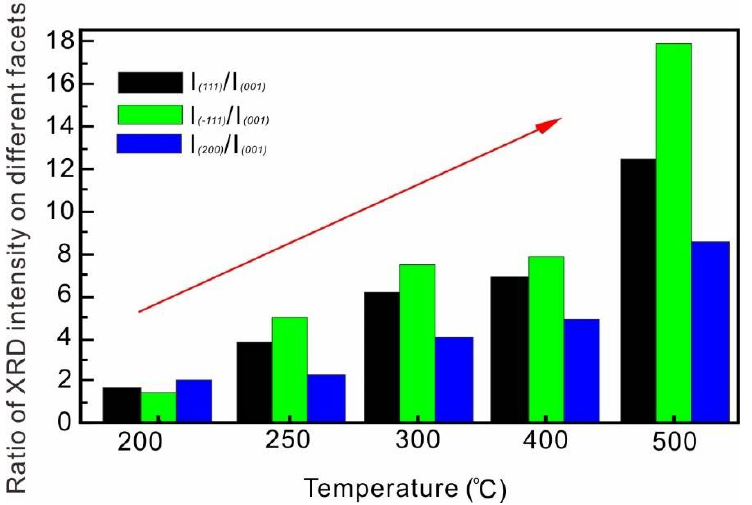
Figure 7. A histogram illustrating the ratios on the μ-XRD intensity of the (111), (−111), and (200) facets compared to the (001) facets. As the temperature increases, all the ratios rise, suggesting that the growth of flank facets causes the thickening of zirconia micro-nanoflakes.